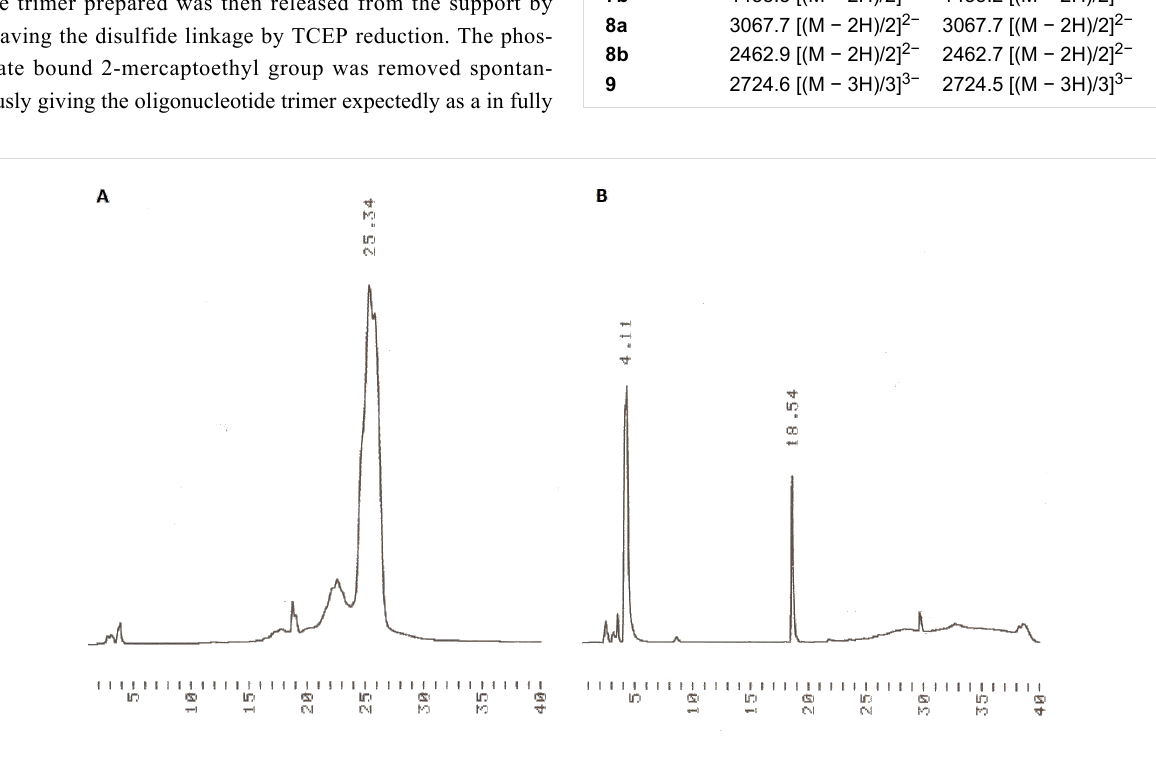
Figure 2: (A) HPLC traces for the precipitated support bearing phosphate-protected 3’-pTpdC Bz -5’- O -DMTr ( 8a ) and (B) HPLC traces of the filtrate after precipitation. For the chromatographic conditions, see gradient B in the Experimental section.